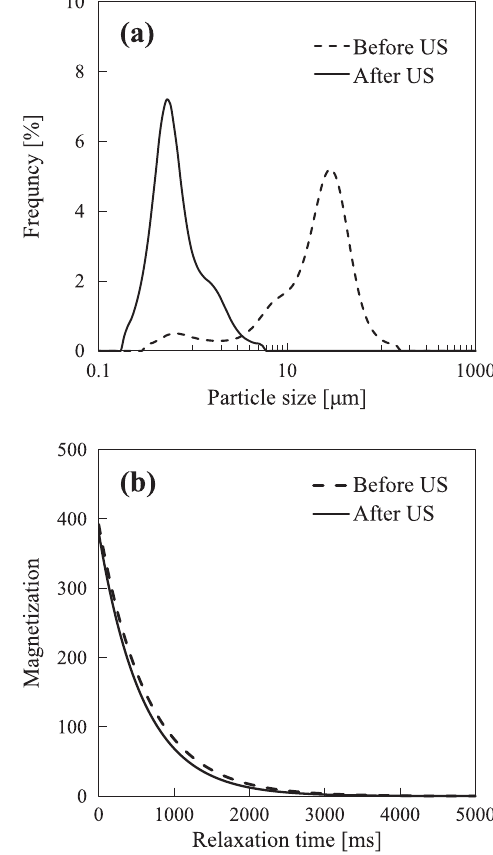
Fig. 3 Changes in (a) the particle size distributions and (b) re- laxation times of the silica particle dispersions before and after ultrasonic (US)